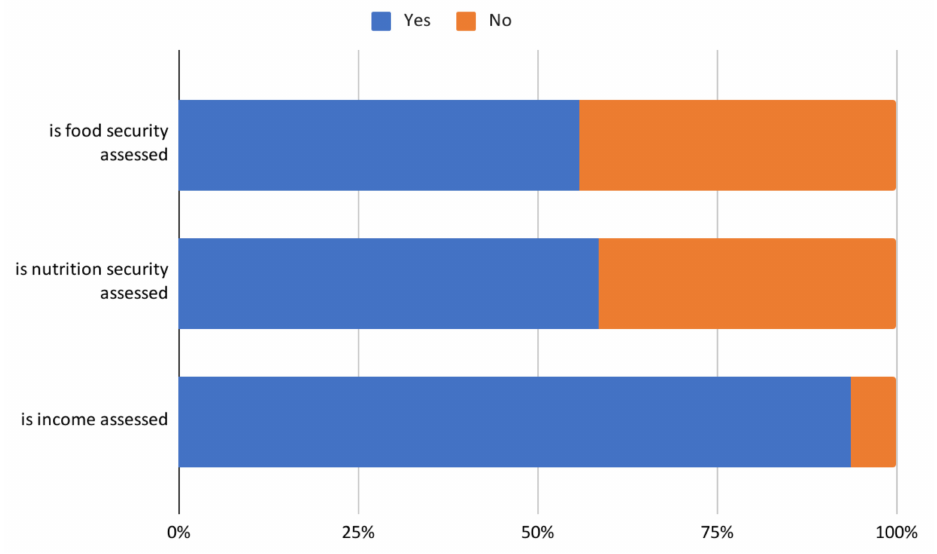
Figure 9. Food and nutrition security, and income.